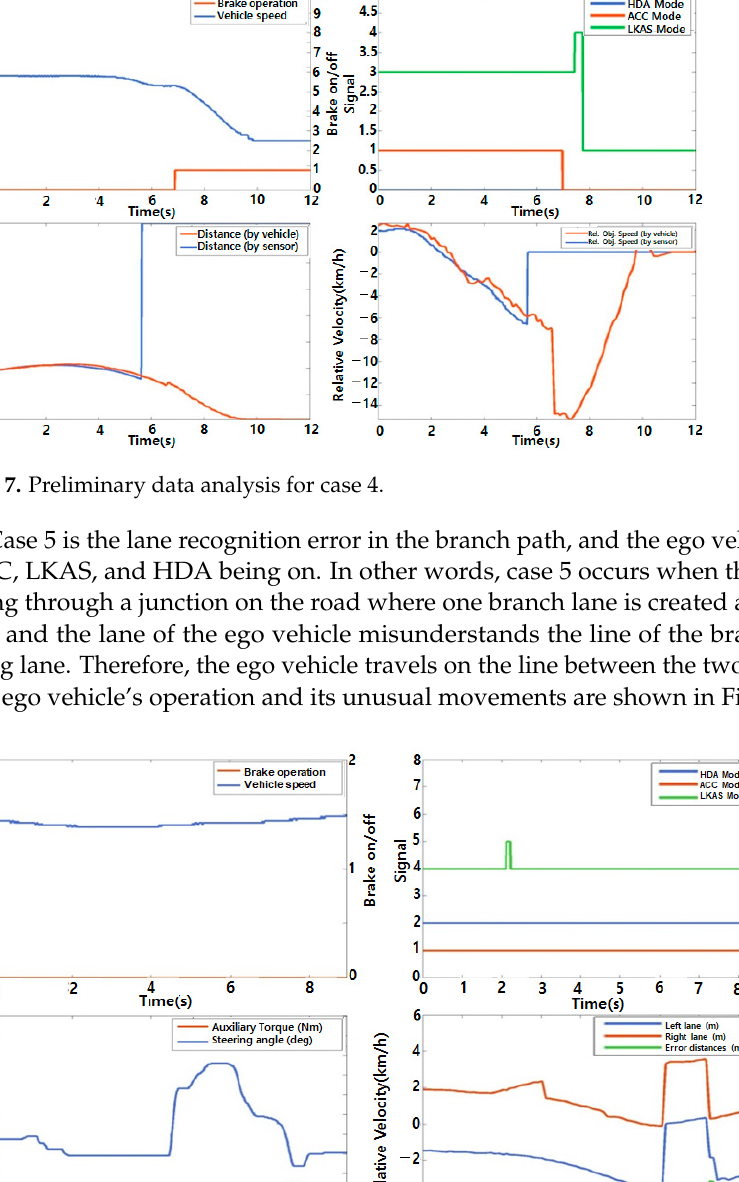
Figure 6. Preliminary data analysis for case 3.